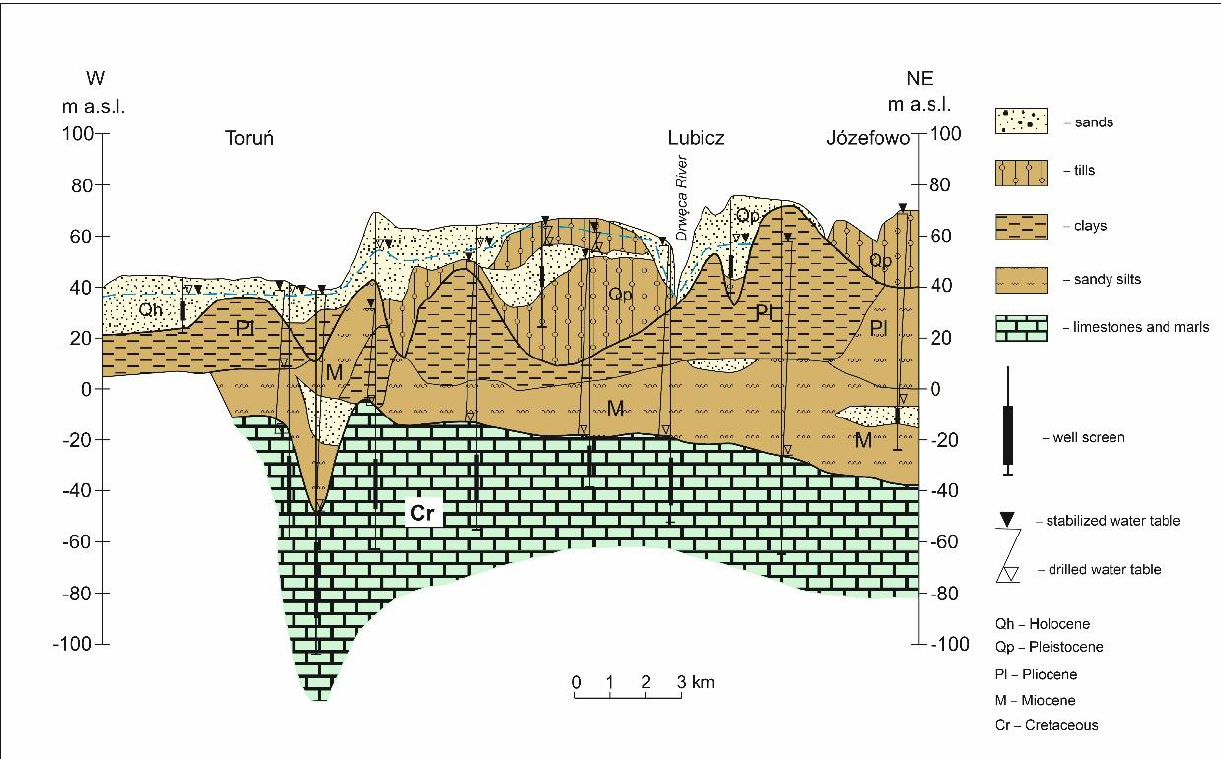
Figure 4. The hydrogeological cross-section of the intake area.